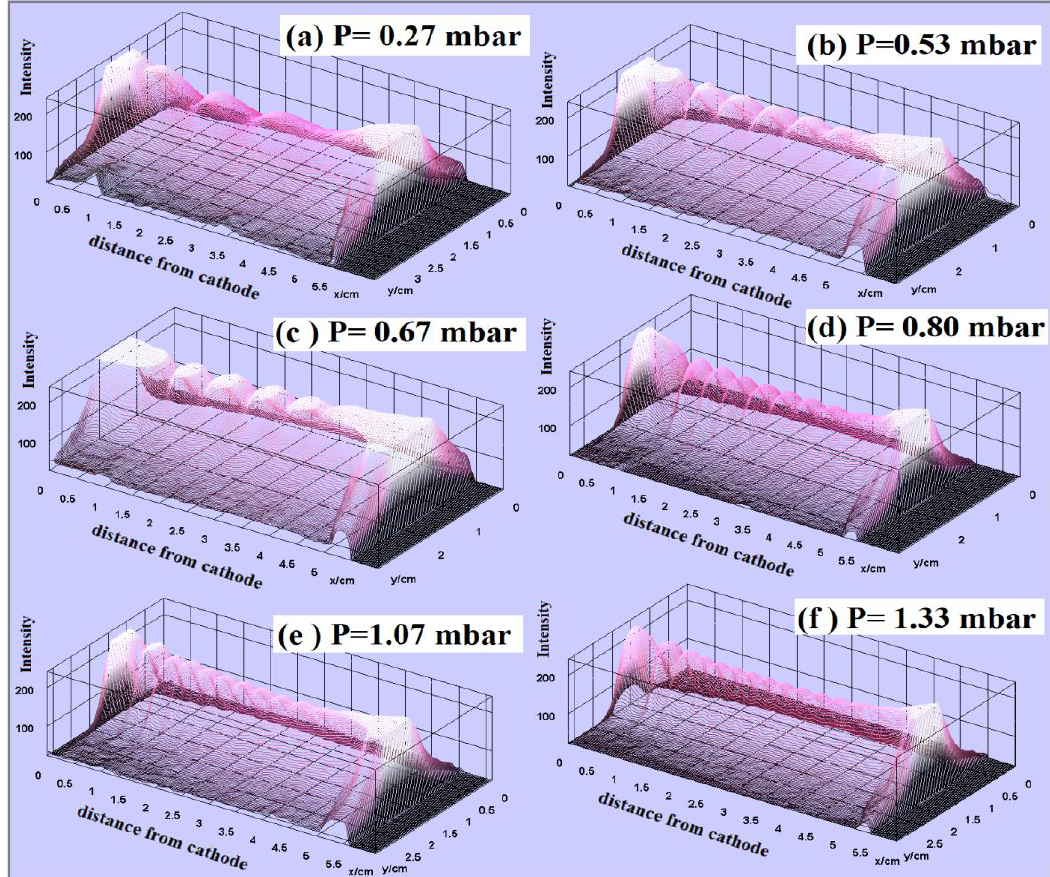
Fig. 5: Three dimensional glow distribution using the hollow cathode system at different working pressure, without magnetic